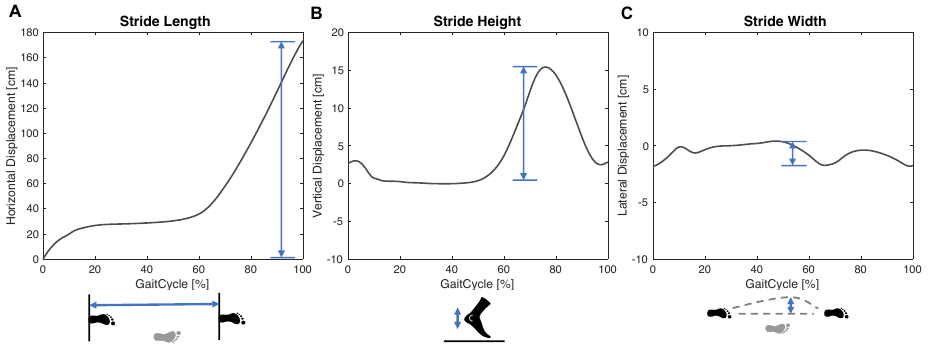
Figure 3. Schematic of the spatial parameter for one gait cycle, which is defined from initial contact to initial contact of the same